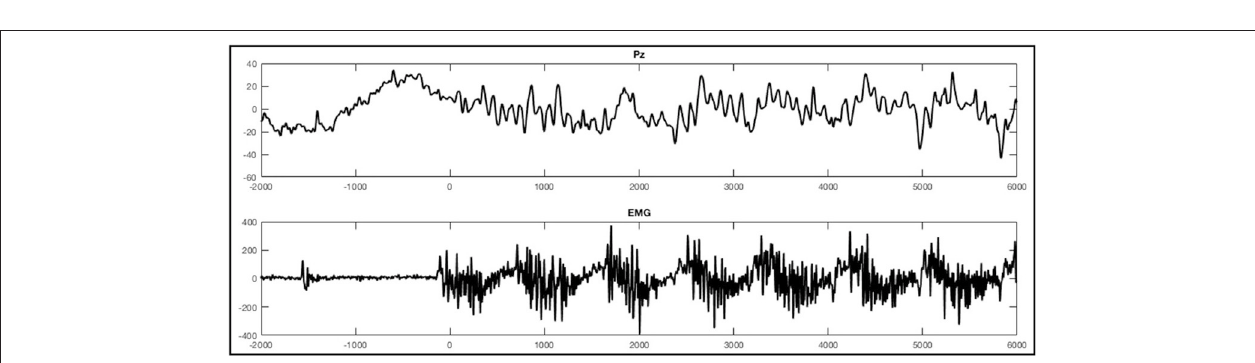
FIGURE 4 | Average ERPs of two healthy subjects recorded on Pz during foot movement execution. Segments are based on stimulus onset (time point 0) and artifacts were excluded strictly. The x-axis displays time (ms) and the y-axis amplitudes ( µ V). Sections shaded in gray indicate significant differences from the resting condition on a single trial level with p <